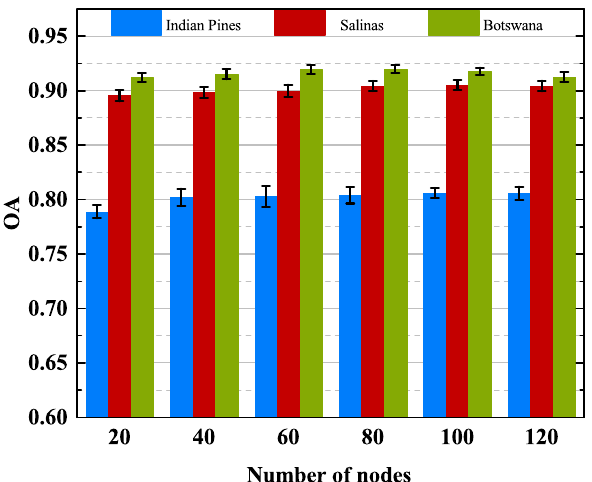
Figure 11. Classification accuracies with numbers of nodes on